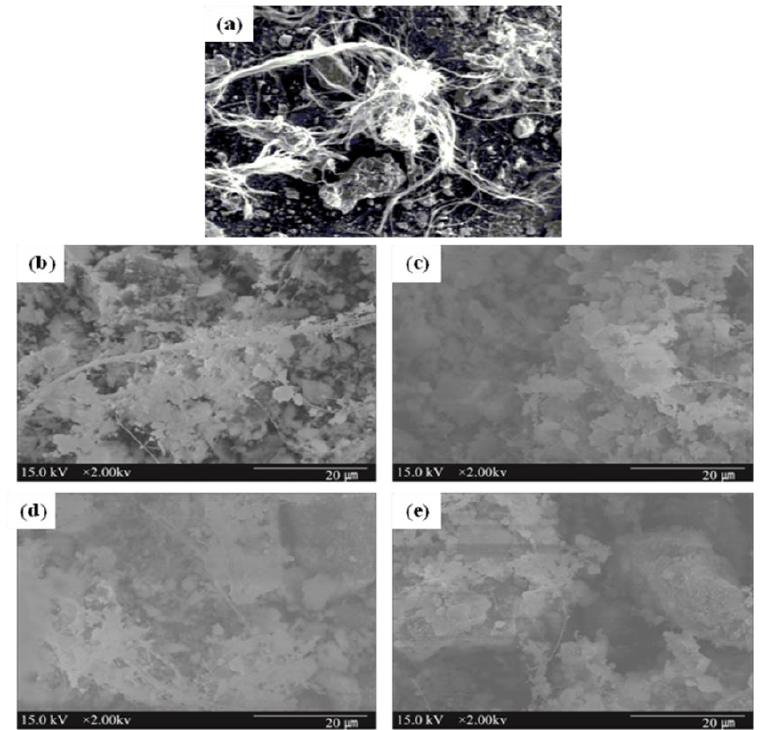
Figure 9. Scanning electron microscope (SEM) images of ( a ) unreacted waste slate and reacted waste slate samples obtained from carbonation tests using the 1 M CH solution at solid dosages of ( b ) 20 g/L, ( c ) 50 g/L, ( d ) 100 g/L, and ( e ) 150